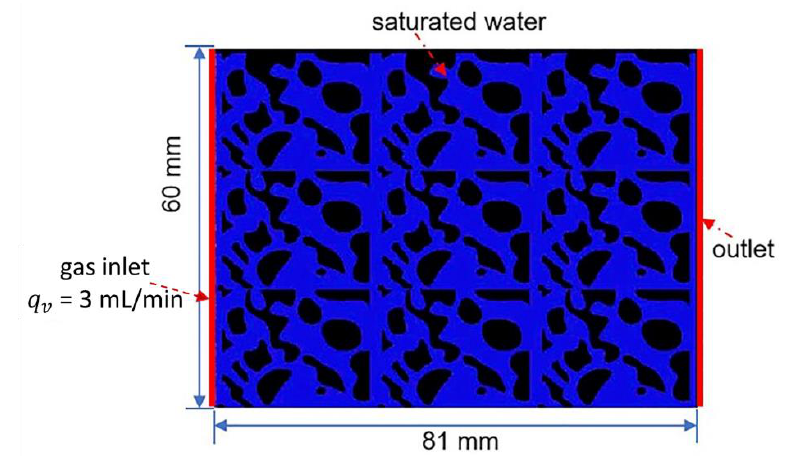
Figure 5. Model geometry and boundary conditions.